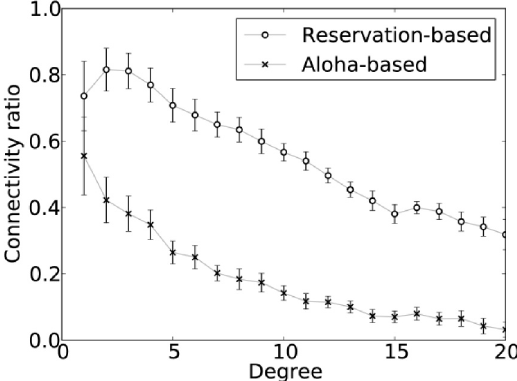
Figure 5. Mean connectivity ratio by degree for bidirectional links in simulated environment.